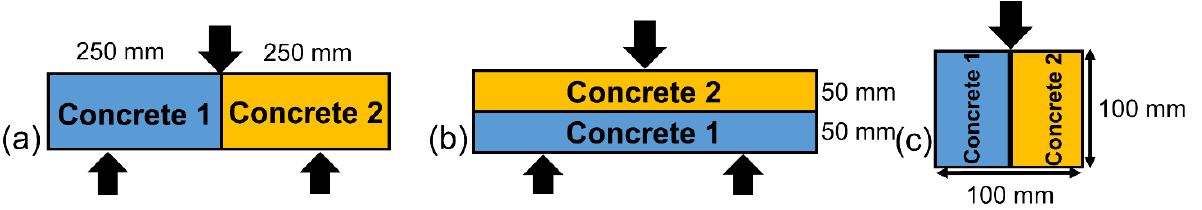
Figure 1. Used test specimen: ( a ) beam with the vertical arrangement, ( b ) beam with horizontal arrangement of layers, ( c ) cube with vertical arrangements .